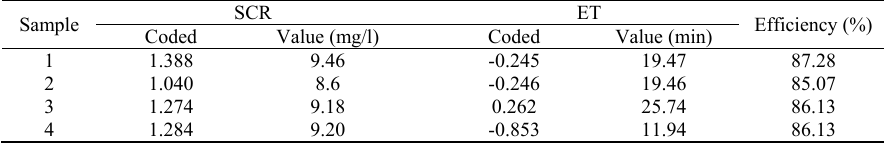
Fig. 4: Surface plot of efficiency Table 7: Four verification tests for the fitted model